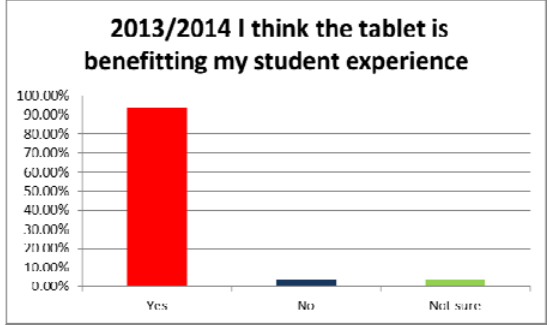
Figure 1. Mobile devices effect on student experience